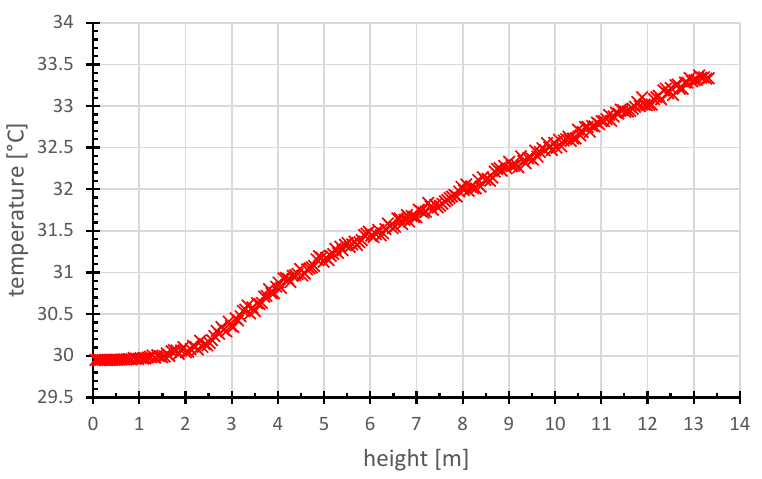
Figure 10. Graph of temperature distribution of air in air gap along façade height in summer extreme.